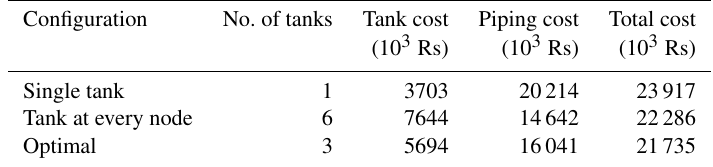
Table 2. Cost of different tank configurations.